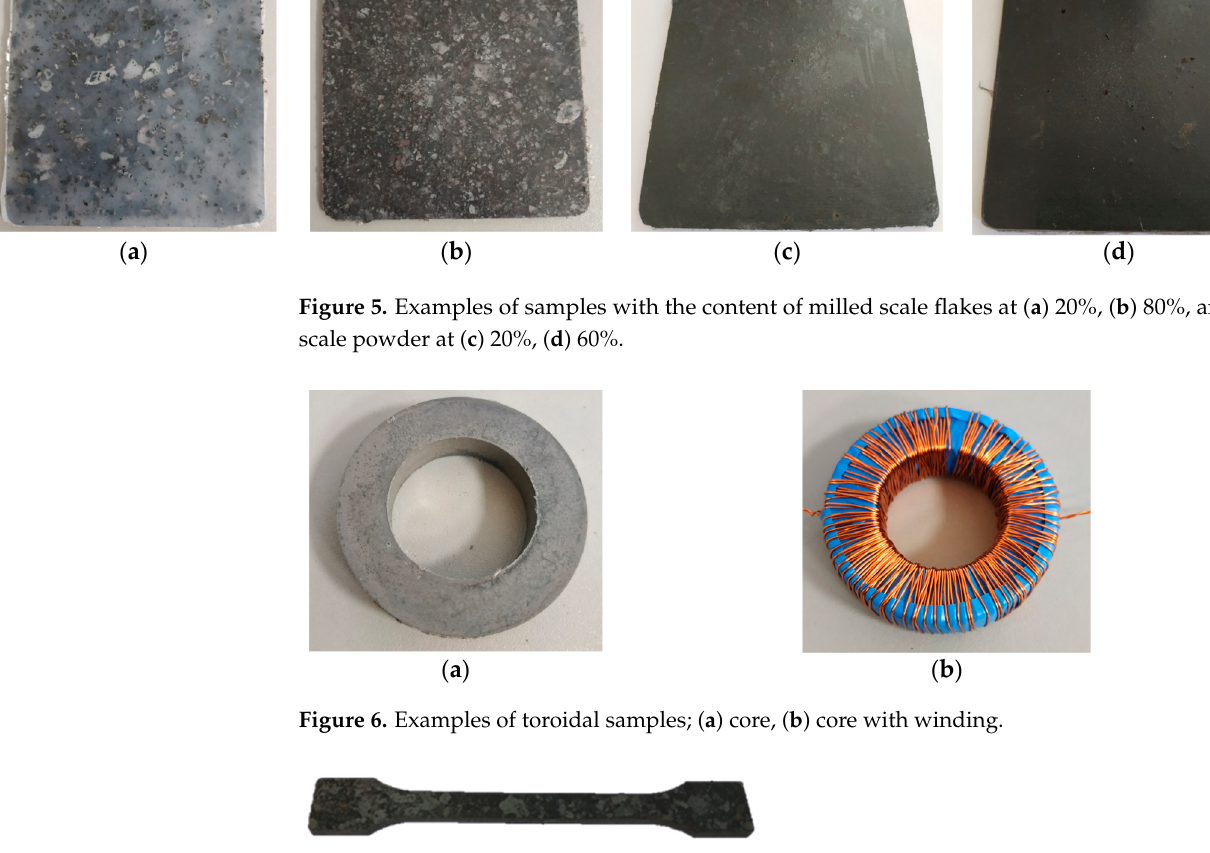
Figure 7. Example of “paddle” sample.